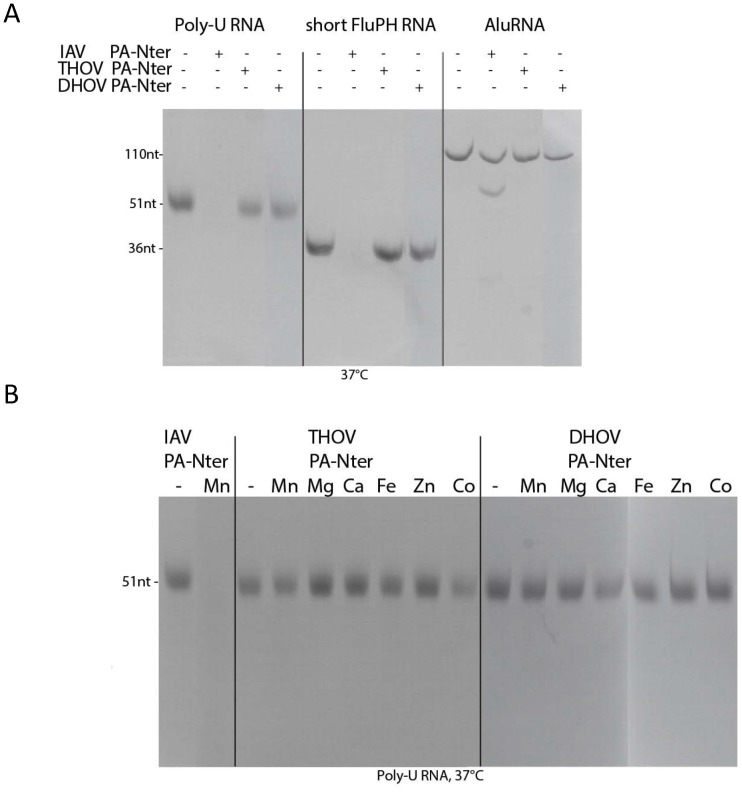
Functional comparison of THOV, DHOV and IAV PA-Nter domains.A. Denaturing urea gel analysis of an endonuclease assay in which IAV, DHOV and THOV PA-Nter domains were incubated at 37°C for 30 minutes in the presence of 1 mM MnCl2 with U-rich RNA (left lanes), short Flu panhandle RNA (middle lanes) or Alu domain RNA (right lanes) as described [16]. IAV endonuclease readily degrades the ssRNA and partially the structured Alu domain RNA, but THOV and DHOV PA-Nter are inactive under these conditions. B. Similar assay with THOV and DHOV PA-Nter and U-rich RNA in the presence or absence of various divalent ions (1 mM MnCl2, MgCl2, CaCl2, FeCl2, ZnCl2 or CoCl2). IAV endonuclease degrades the RNA in the presence of manganese but THOV PA-Nter does not degrade the RNA with any cation.